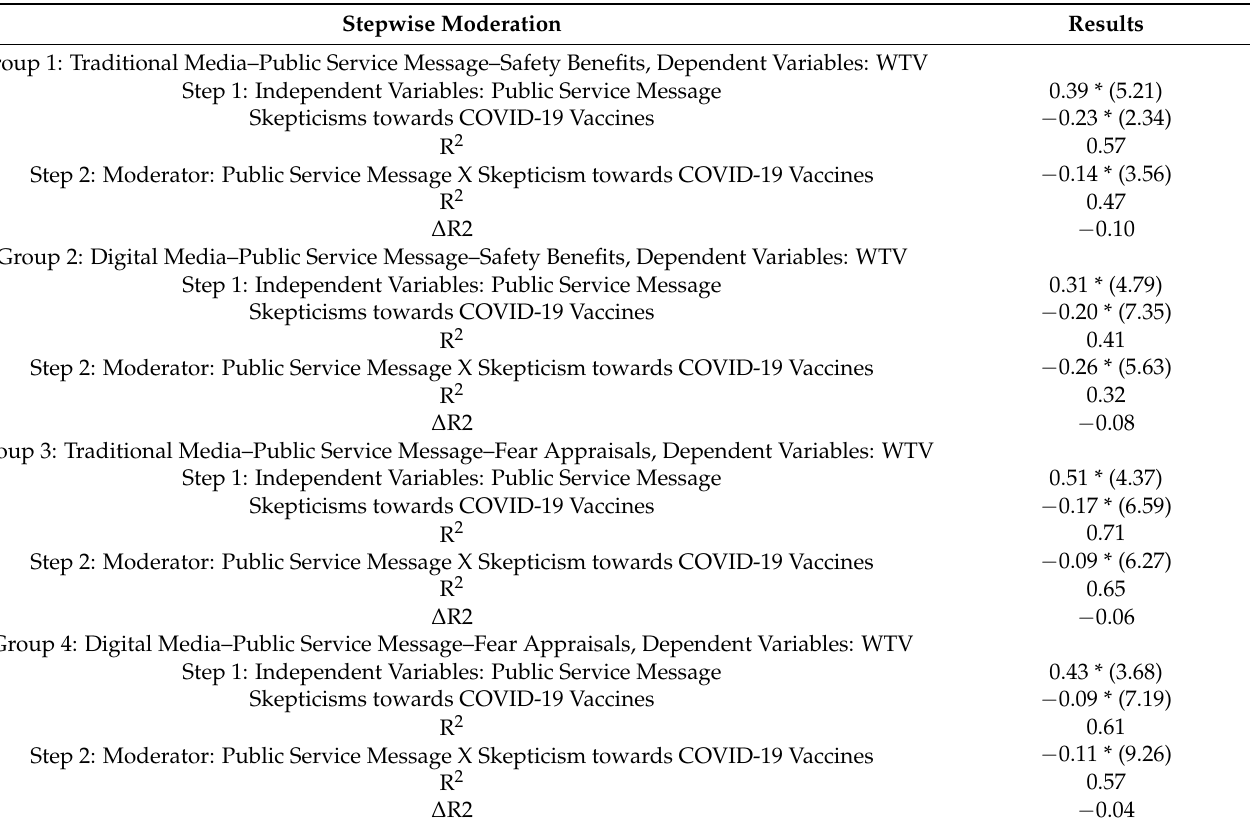
Table 6. Moderation